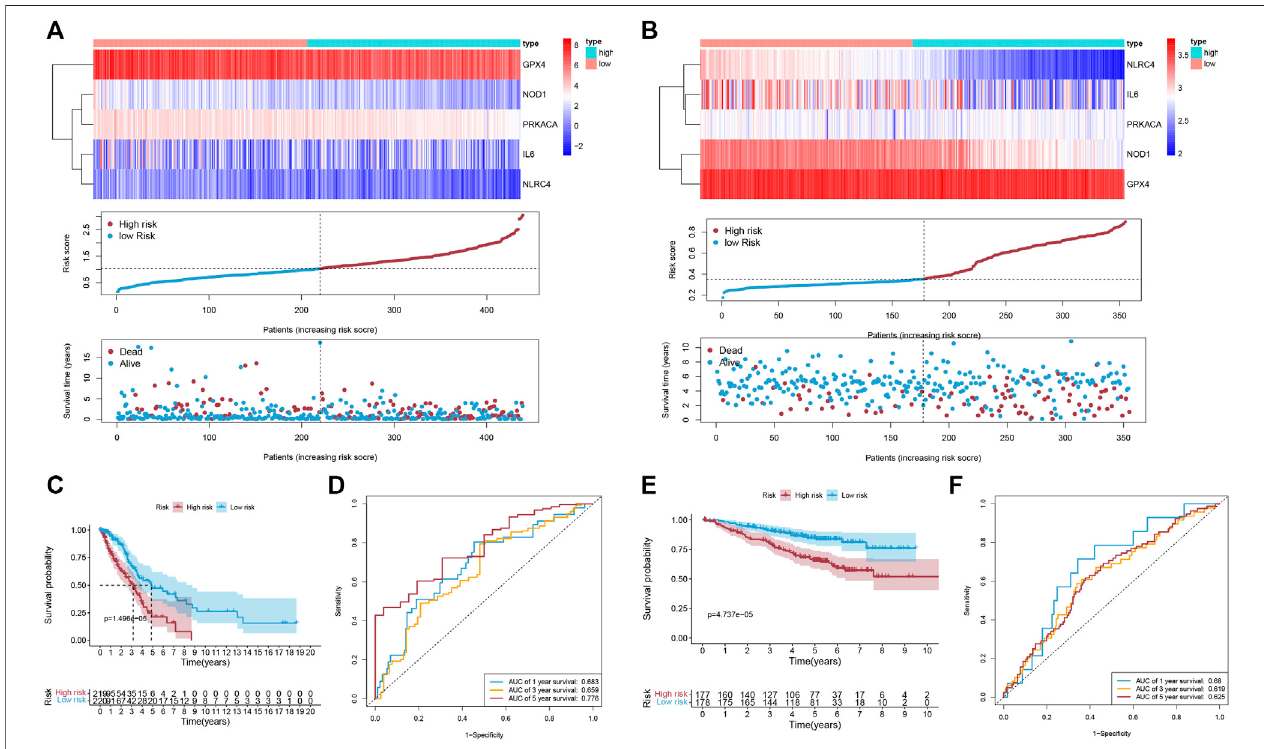
FIGURE 3 | The accuracy of the prognostic model. (A,B) The gene expression pattern; distribution of risk scores between the two groups; distribution of survival status in the training cohort (A) and validation cohort (B) . (C,E) K-M survival curves of OS in the training cohort (C; p = 1.496e-05) and validation cohort (E; p = 4.737e-